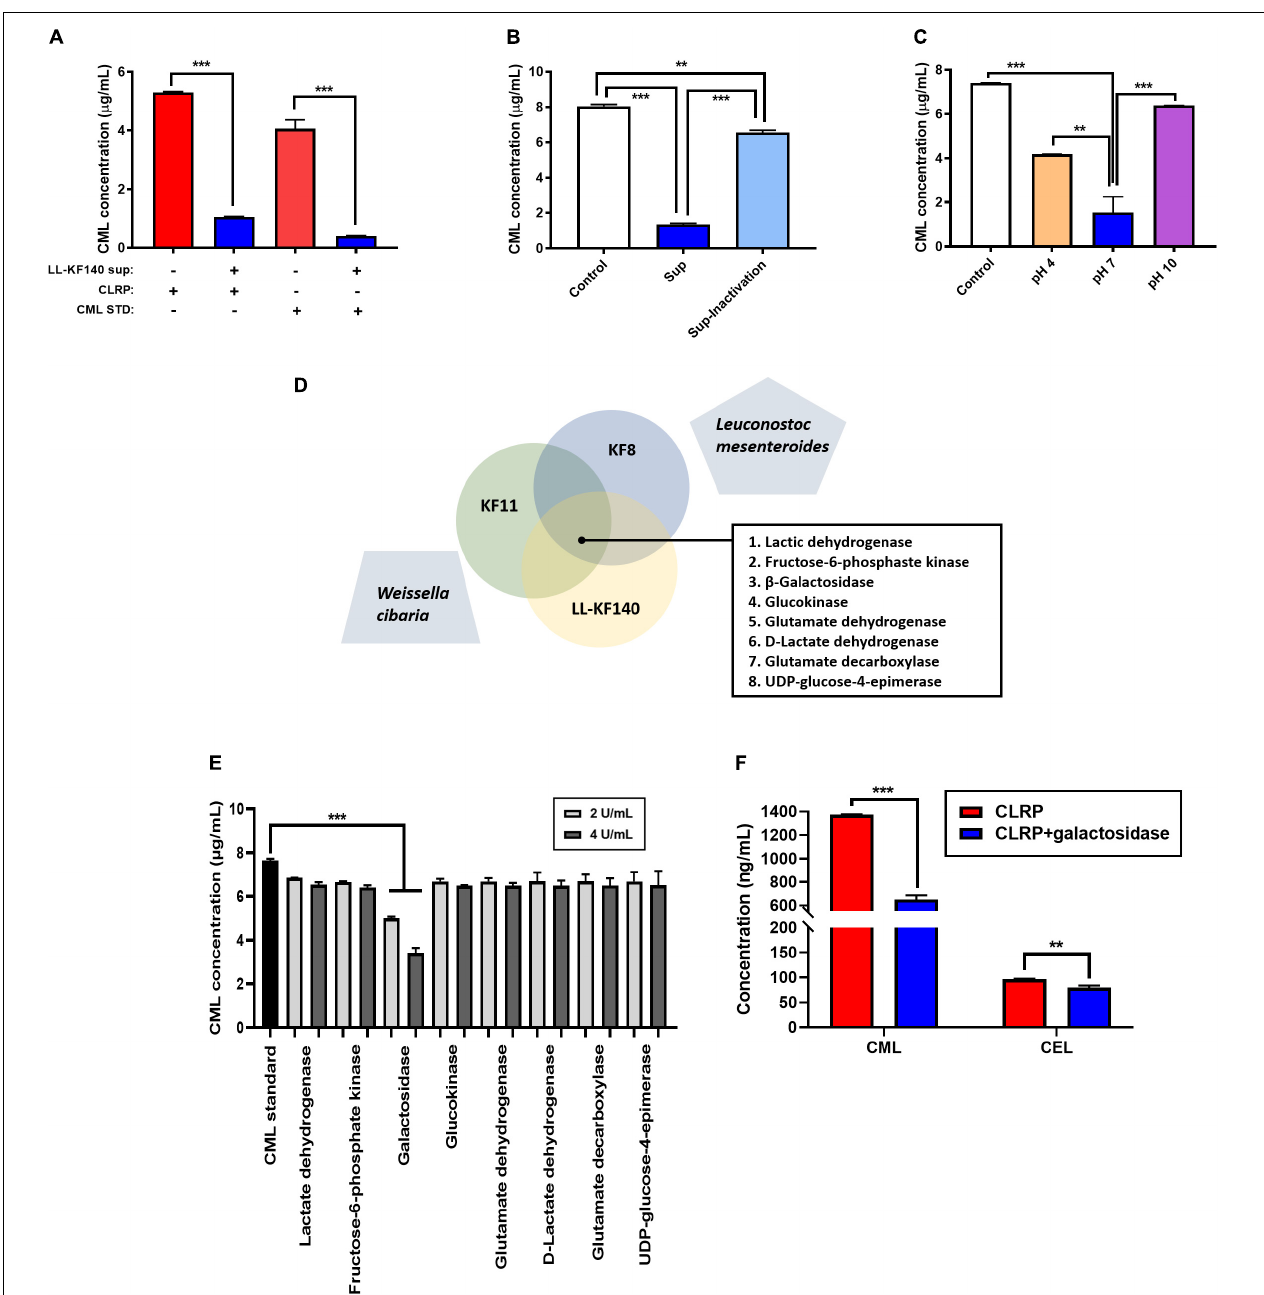
FIGURE 4 | In vitro effects of the Lactococcus lactis KF140 (LL-KF140) culture supernatant and related enzymes on N ε -(Carboxymethyl)lysine (CML) levels. (A) CML levels in the casein-lactose reaction product (CLRP) and synthetic CML after incubation with the LL-KF140 supernatant. (B) Effects of the LL-KF140 supernatant, with and without heat inactivation, on CML levels. (C) Effects of the LL-KF140 supernatant on CML levels under different pH conditions. (D) Selected enzymes that could potentially reduce the levels of CML. (E) Effects of LL-KF140-producing enzymes on CML levels. (F) Effects of β -galactosidase on CML and N ε -(carboxyethyl)lysine (CEL) levels. Data are presented as the mean ± SD ( n = 3). ** p < 0.01, *** p < 0.001 (one-way ANOVA, followed by Tukey’s test, or a paired two-tailed Student’s t